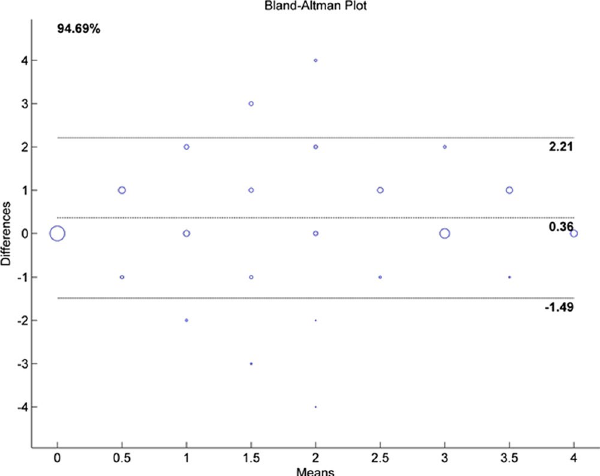
Figure 2. Bland-Altman plot for all slices. Bubble size is proportional to the number of